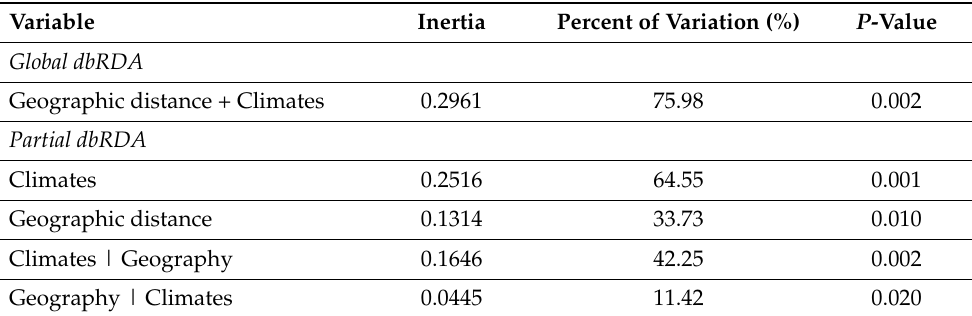
Table 3. Effect of geographic and climatic factors on COI sequence